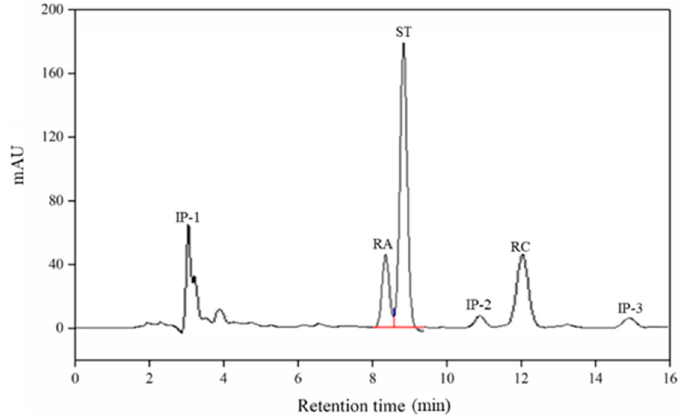
Figure 5. HPLC chromatogram of the liquid phase after first crystallization at 210 nm wavelengths.